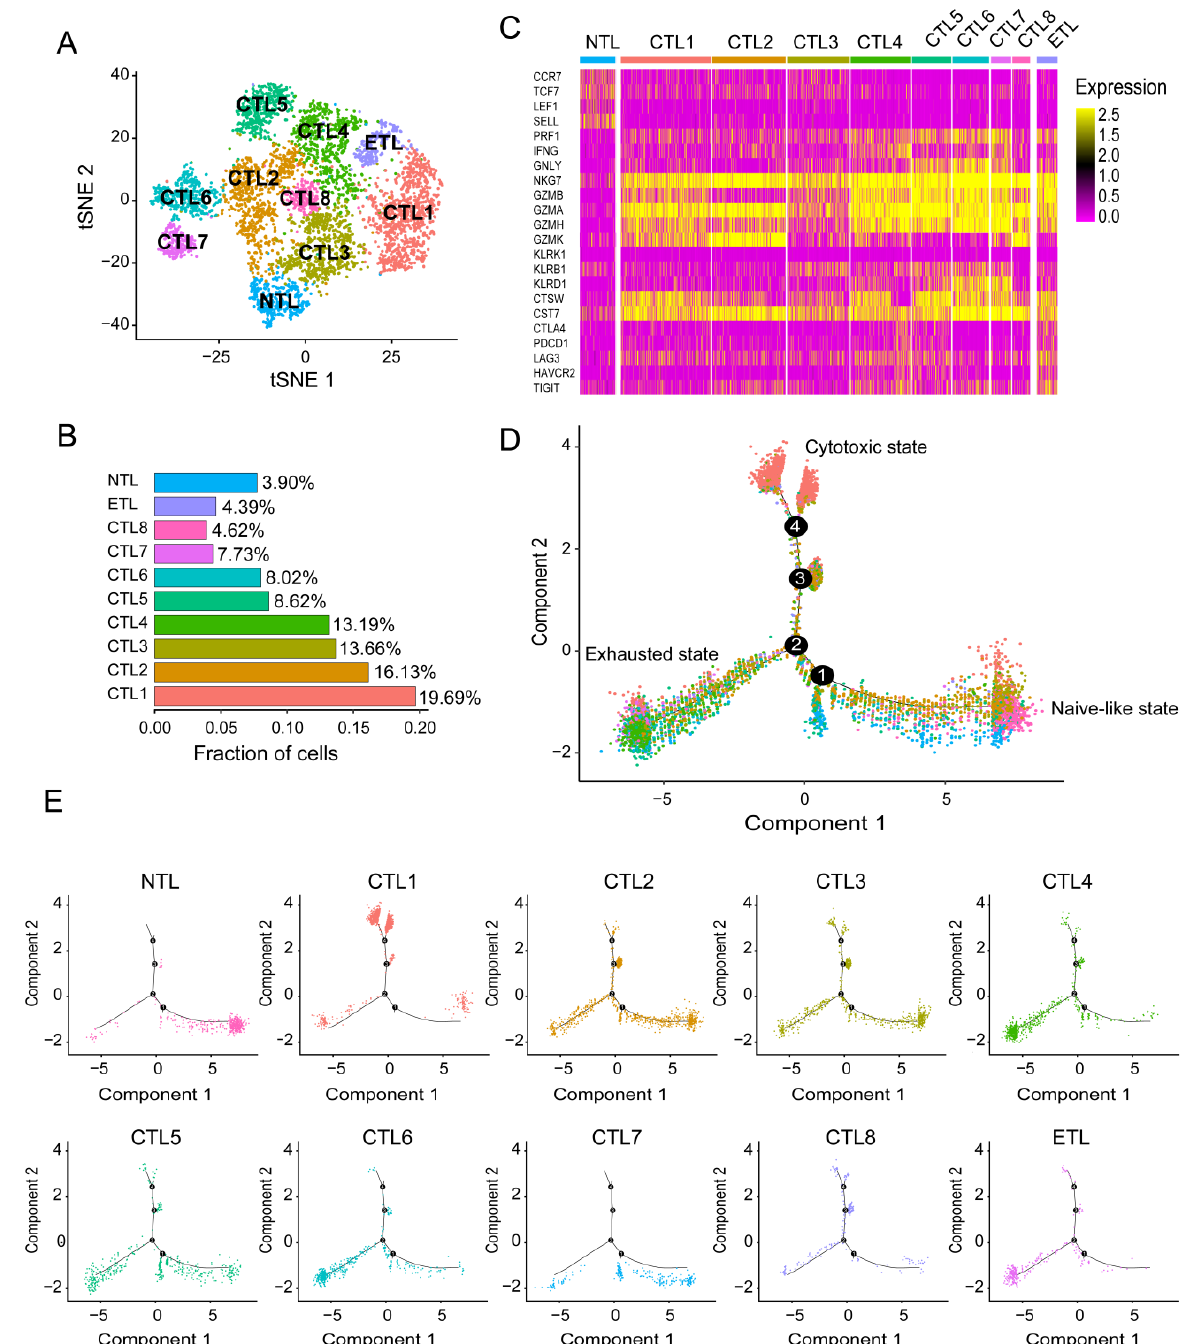
Figure 1. CD8+ T cell subsets and cell differentiation trajectories. ( A ) Cluster map of ten. CD8+ T cell subsets, including one NTL subset, eight CTL subsets, and one ETL subset. ( B ) Proportion of ten CD8+ T cell subsets. ( C ) Heatmap of marker gene expression for ten CD8+ T cell subsets. ( D ) Comprehensive cellular differentiation trajectories of ten CD8+ T cell subsets. A typical cell differentiation trajectory is from the naive-like state to the cytotoxic state, and then to the exhausted state. ( E ) Individual cell differentiation Trajectories for ten CD8+ T cell